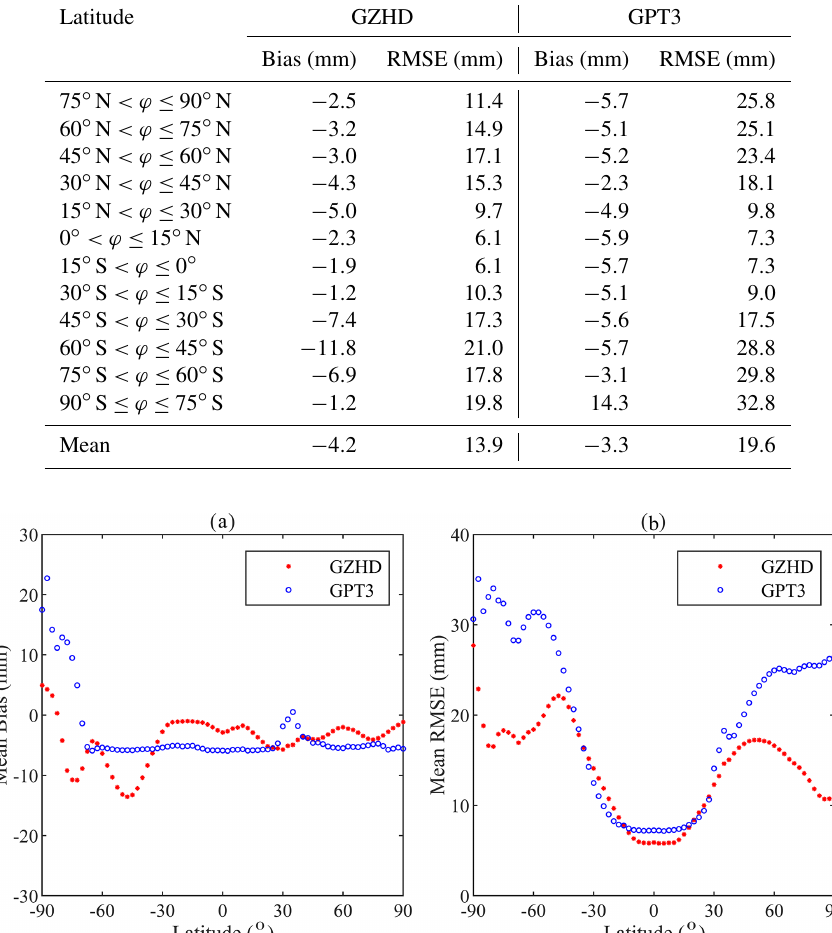
Figure 9. Mean biases (a) and RMSEs (b) of two model-derived ZHDs during the 20-year period of 2000–2019 in different latitude ranges (with a 2.5 ◦